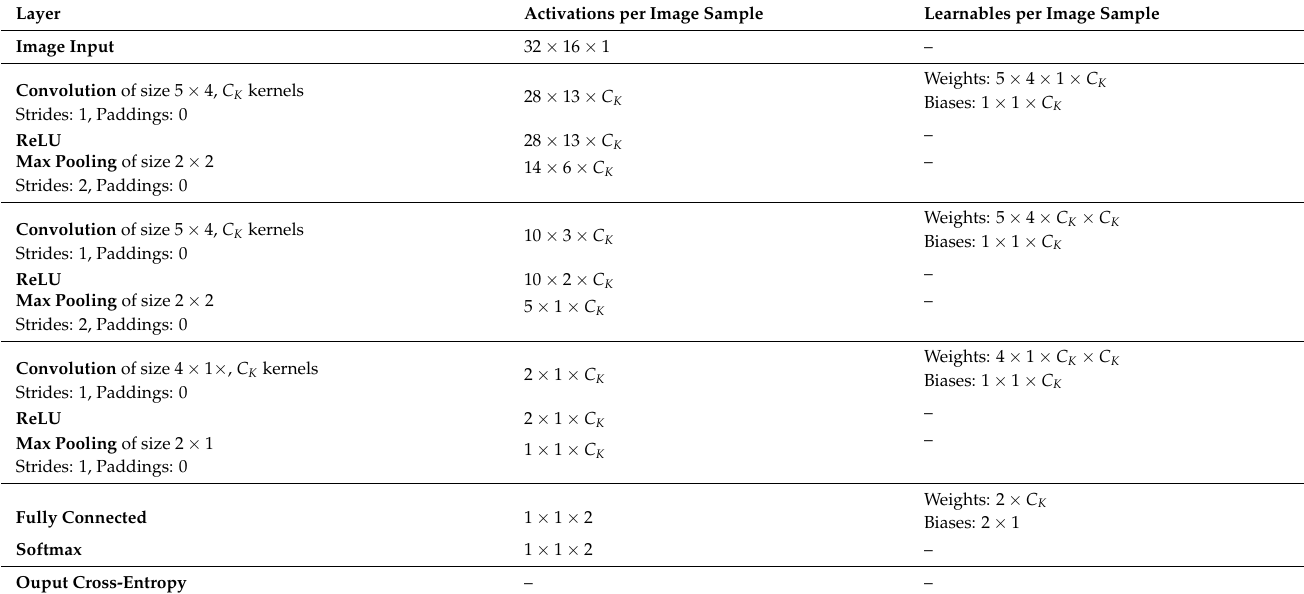
Table 1. The CNN architecture of 3 stacks used for this research. The number of kernels in convolutional layers is variable, and it took values C K 8,12,16,20,24,28,32 . Part of this illustration is also valid for CNN architectures of 1 or 2 stacks ∈ { } (also implemented in this research), in which the image input layer is followed by the next three or six layers as feature extractor, respectively, and then by the fully connected layer until the output cros-entropy layer in the classification stage. All of these CNNs were implemented with the MATLAB Deep Learning Toolbox